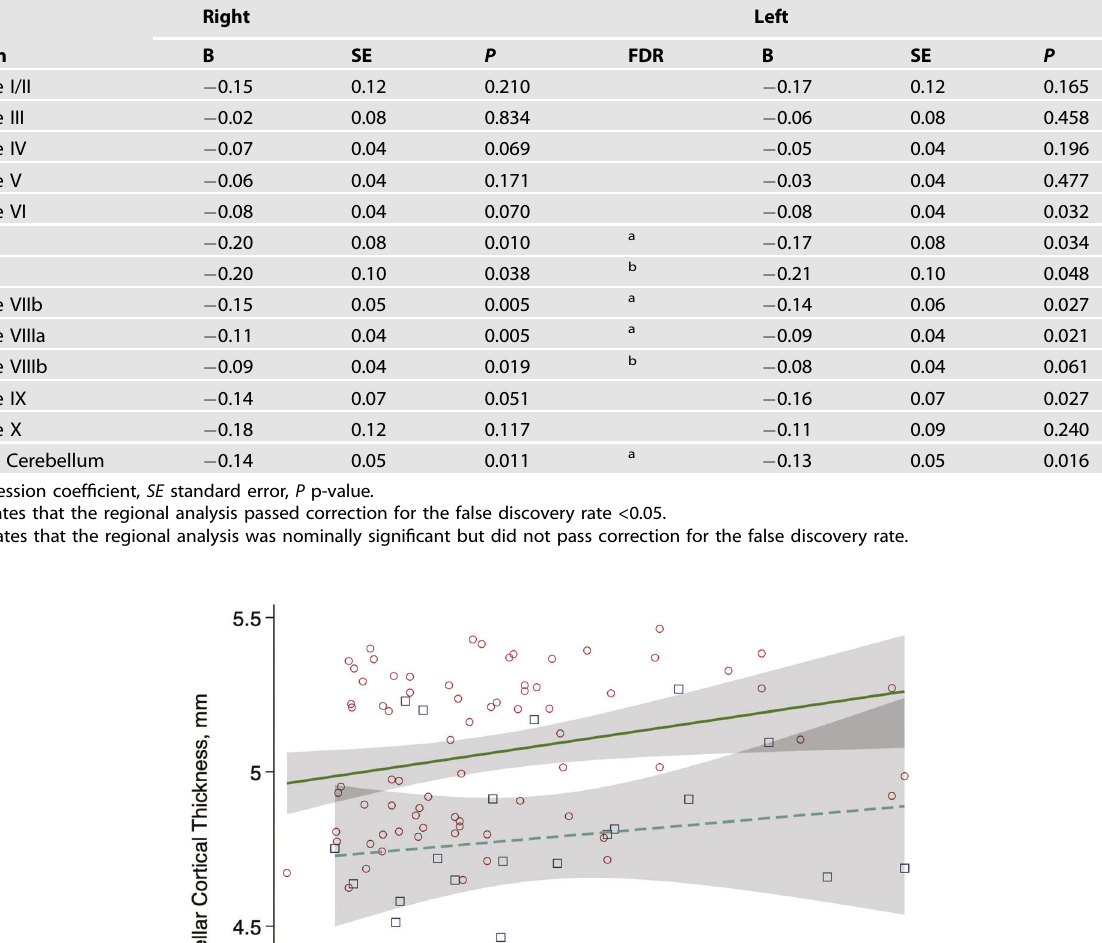
between episodic memory and cerebellar cortical thickness in Lobules VIIb, VIIIa, VIIIb, and IX. Analyses also showed associations between response speed and cerebellar cortical thickness in the Crus I and II (Appendix Fig. 1). Comparison with atrophy in neurodegenerative disorders Interpretation of regional fi ndings for reduced cerebellar cortical thickness in WTC responders with CI to known neuropatholo- gical conditions derived from results described in a meta- analysis of patterns of cerebellar atrophy shown in Table 3. Multi-region risk scores identi fi ed no clear signal indicating a single conditional etiology for WTC responders with CI, though orthogonalized results suggested that the overall cerebellar pattern was more indicative of disease state than disease- speci fi c indices (Table 3).